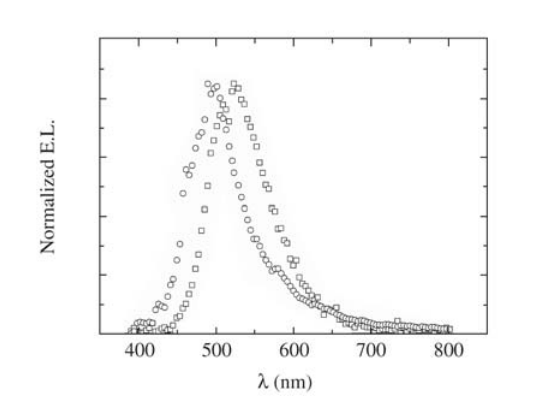
Figure 3. J × V characteristics of a FTO/PEDOT:PSS (50 nm)/ Figure 5. Electroluminescence (EL) spectrum of FTO/PEDOT:PSS OPPVDBC (20 nm)/Ca/Al device (circles) and a FTO/PEDOT:PSS (50 nm)/OPPVDBC (20 nm)/Alq (45 nm)/Ca/Al device at 8.5 V 3 (50 nm)/OPPVDBC (45 nm)/Alq (45 nm)/Ca/Al device (squares); (noise filtered). Circles: Electroluminescence spectrum of FTO/ 3 R. Lessmann et al. PEDOT:PSS (50 nm)/OPPVDBC (20 nm)/Al/Ca device at 13 V; R. Lessmann et al.